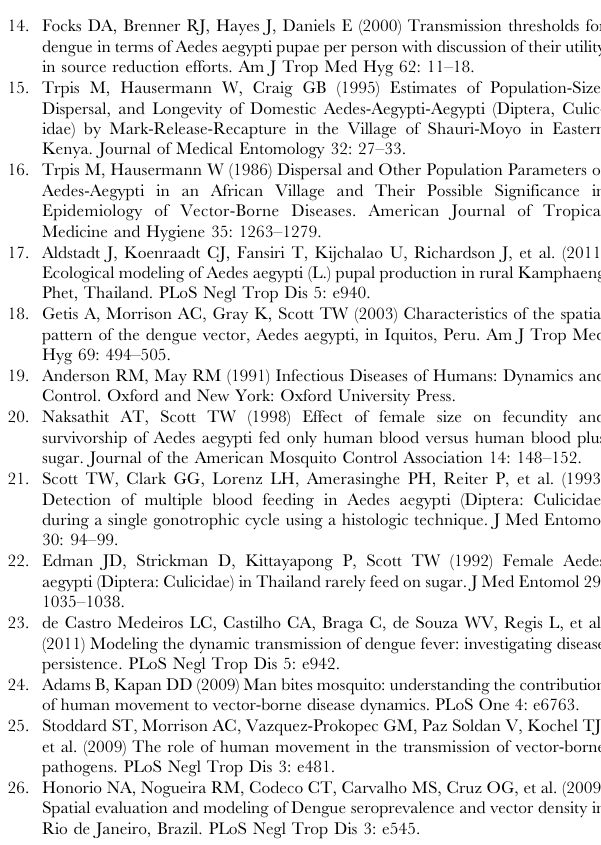
Table S1 Summary of parameter descriptions, values/ distributions and